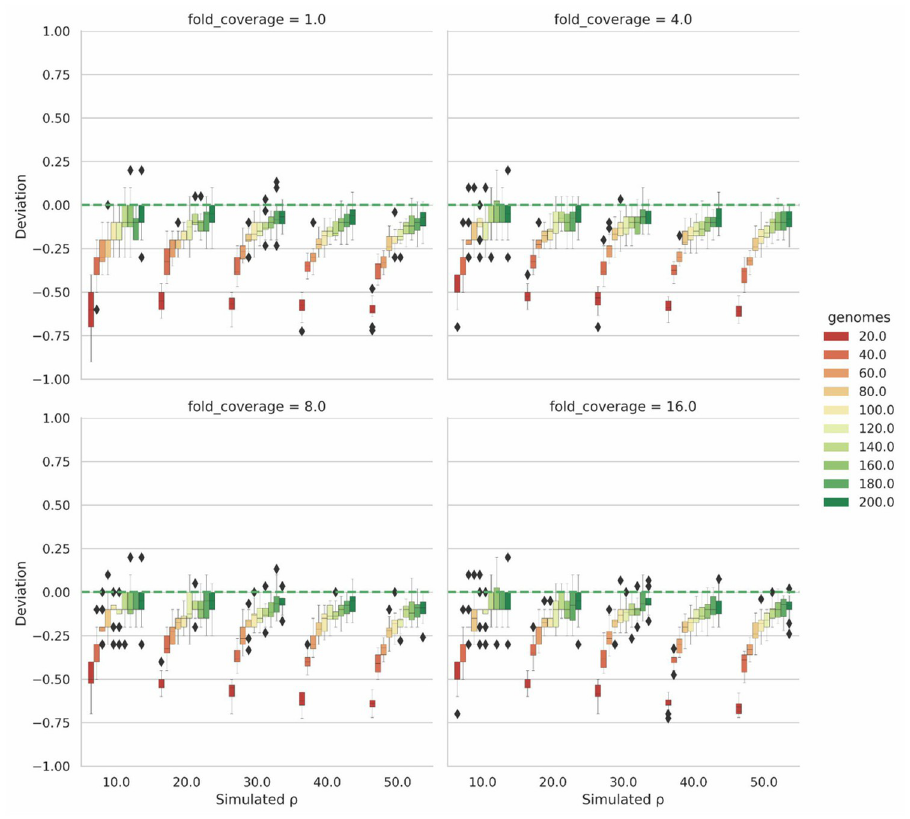
Fig 4. Deviation plot for results in Fig 3. Deviation is calculated as (Estimated ρ (median)—Simulated ρ ) / Simulated ρ . Deviation results corresponding to Fig 3 for population recombination rates 10.0, 20.0, 30.0, 40.0, 50.0.